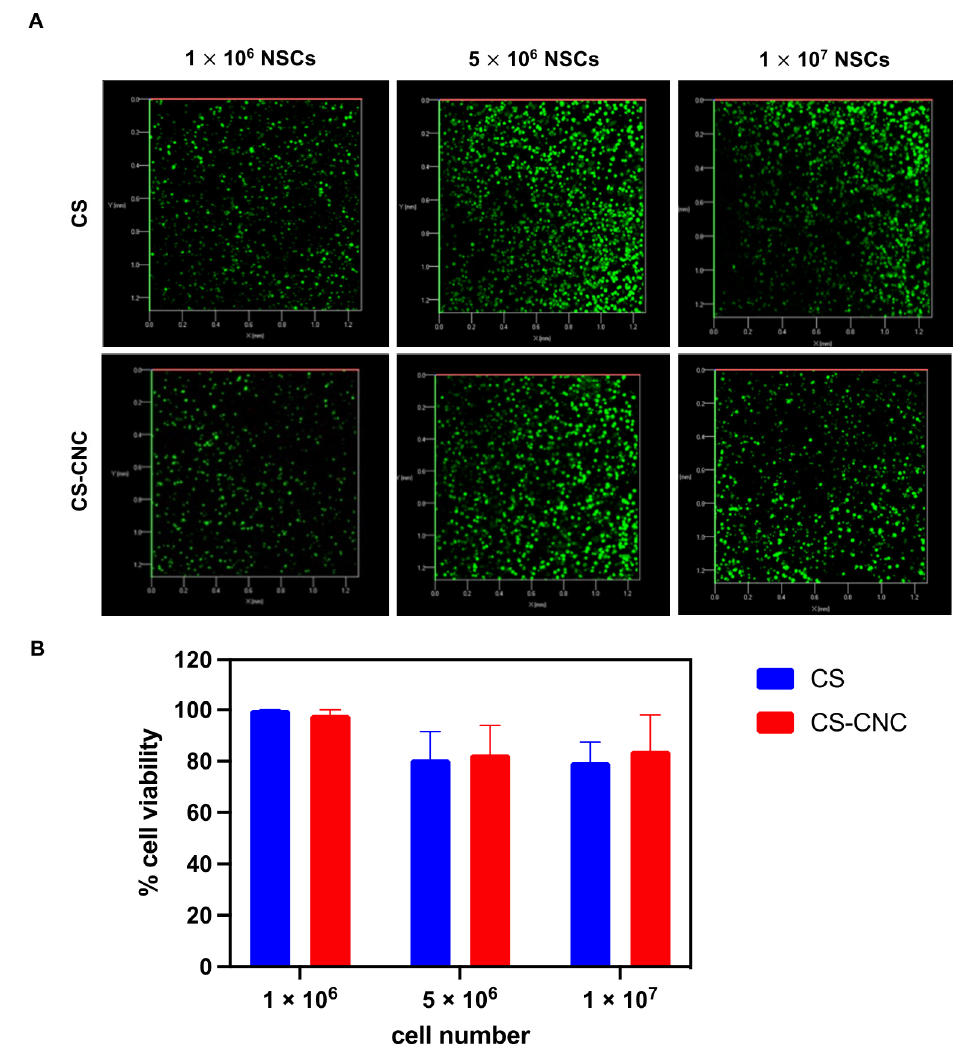
Figure 6. In vitro cell viability within hydrogel matrices. ( A ) Confocal fluorescent images of NSC- hydrogels (10 6 –10 7 NSCs/mL hydrogel) post 24 h incubation ( n = 3; 200 μ L samples; x - and y -axis hydrogels (10 6 –10 7 NSCs/mL hydrogel) post 24 h incubation ( n = 3; 200 µ L samples; x - and y -axis 0.0–1.2 mm). ( B ) Graphical representation of NSC viability. 0.0–1.2 mm). ( B ) Graphical representation of NSC